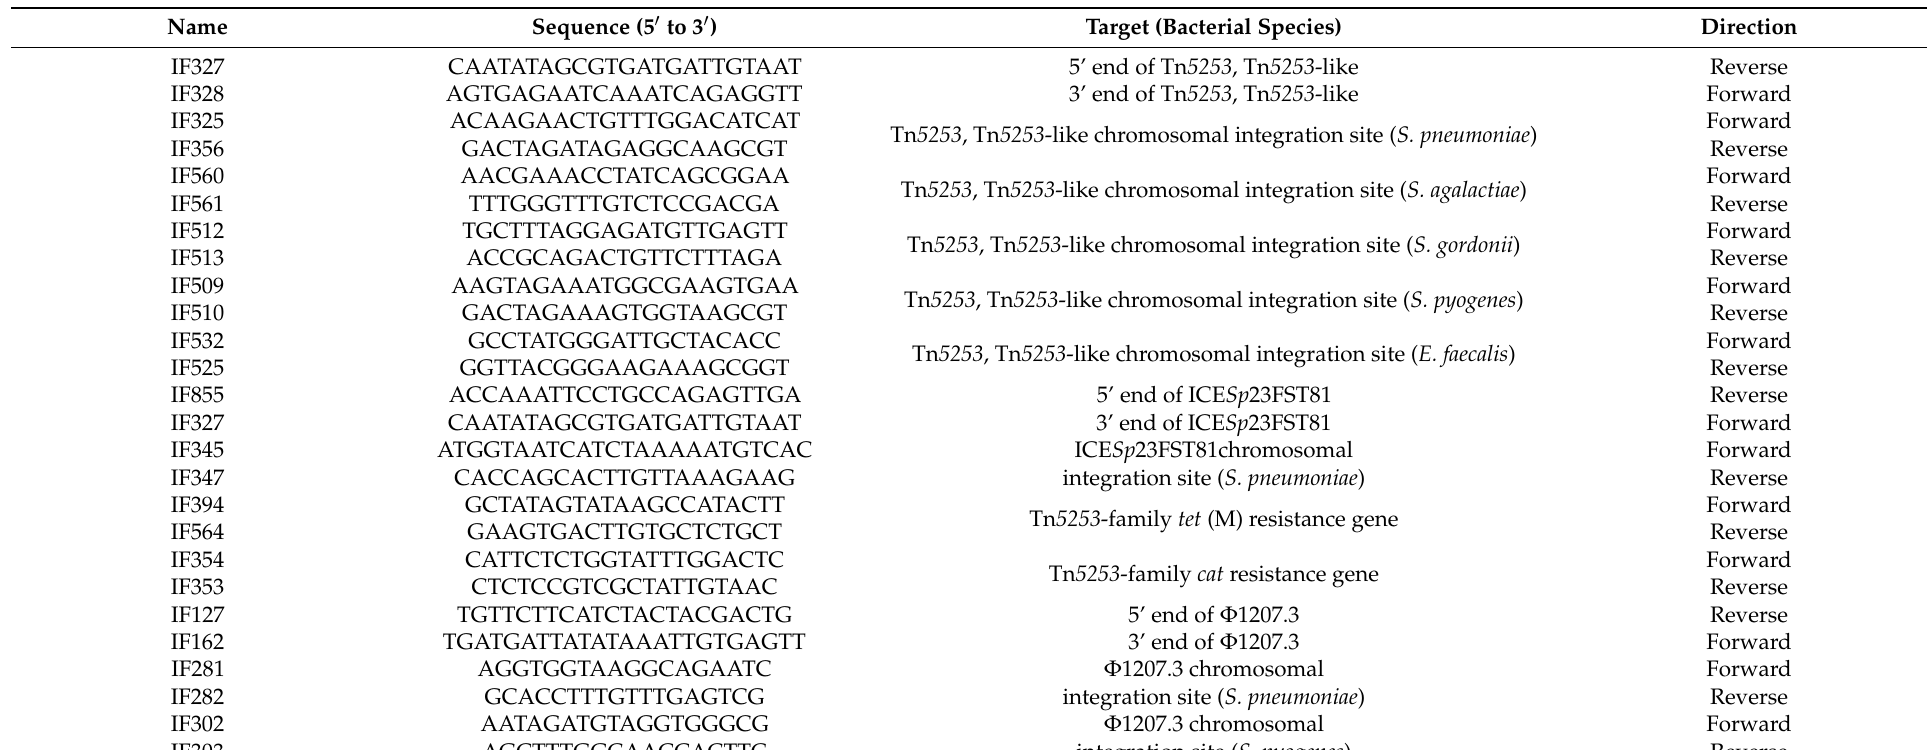
Table 2. PCR oligonucleotide primers for transconjugants